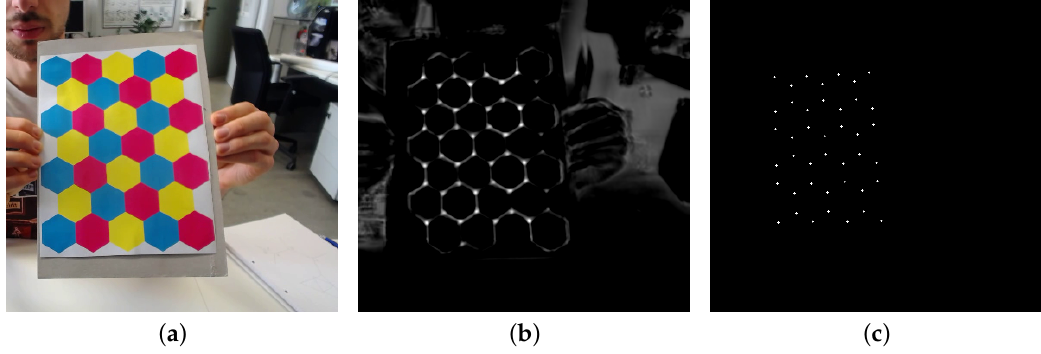
Figure 13. Result for the neural net trained on a CMYK hexboard input. The input image ( a ); the response map ( b ); and the detected calibration template corners ( c